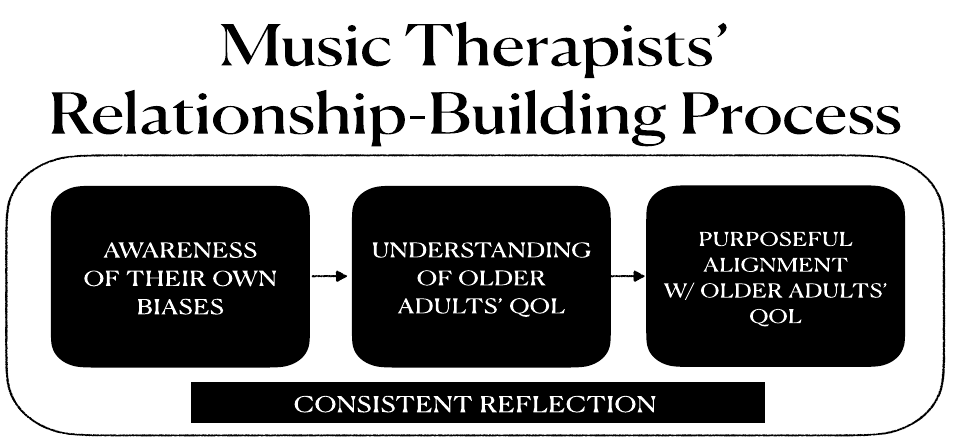
Figure 1. A flow map of music therapists’ perspectives permeated in relationship-building process. “(Self-reflection) helps me have a better understanding about myself and what quality of life means to me” (PT9).